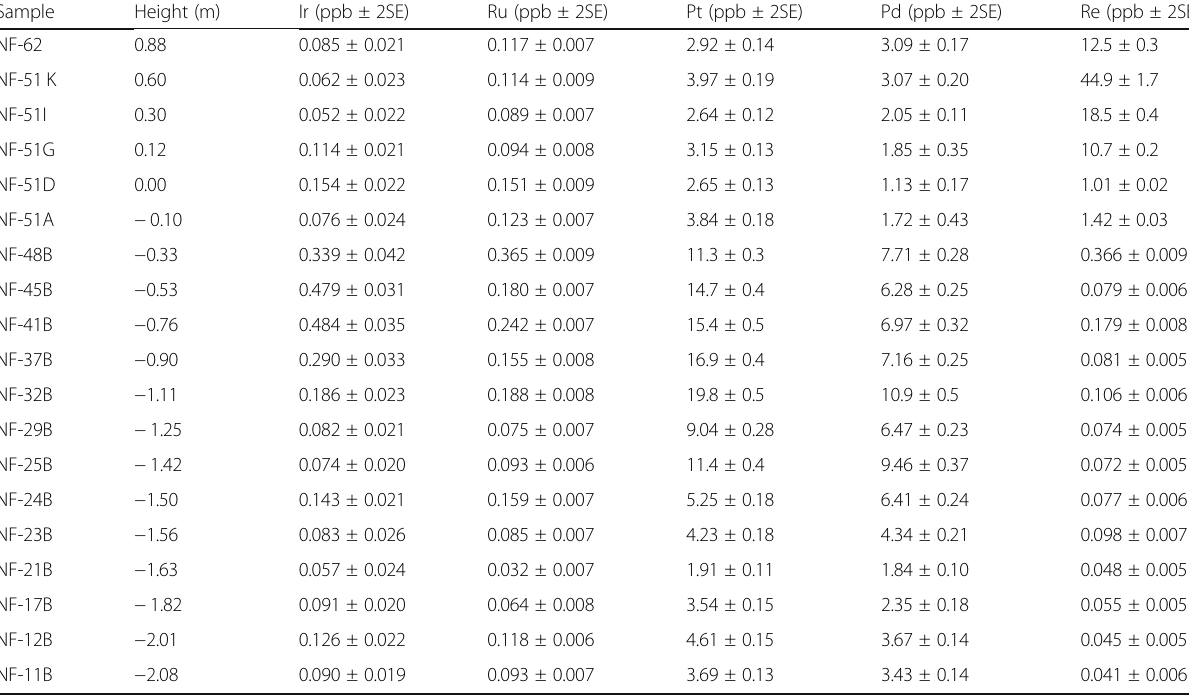
Table 2 PGE concentrations in claystone samples from the Waidani section